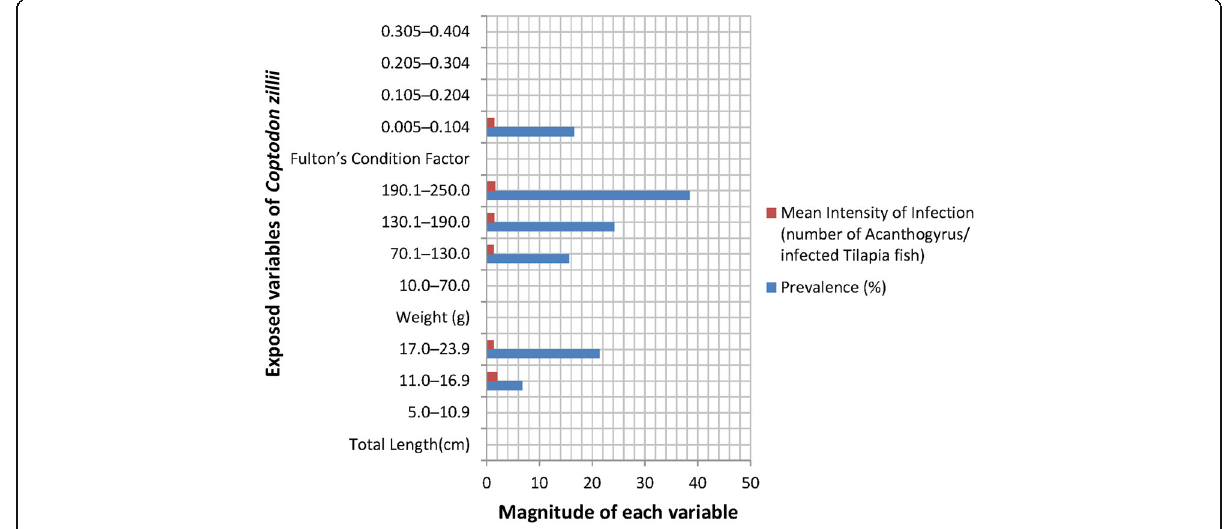
Fig. 2 Bar chart showing the prevalence and intensity of the infection with respect to significant exposed